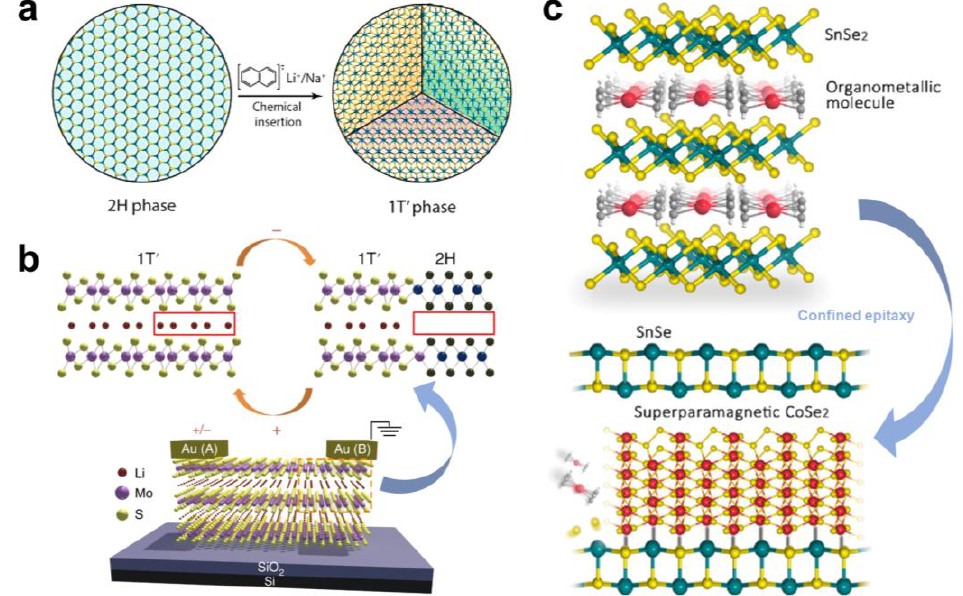
Figure 9. ( a ) Schematic diagram of the 1T’-MoS 2 lattice structure with three orientations formed after lithium intercalation. Reproduced with permission from Ref. [86]. Copyright 2016, American Chemical Society. ( b ) Schematic diagram of the 2H-1T’ phase transition in the MoS 2 lattice by controlling the flow of Li + ions. Reproduced with permission from Ref. [90]. Copyright 2018, Springer Nature. ( c ) Schematic diagram of vdW epitaxial growth of CoSe 2 -SnSe heterostructure. Reproduced with permission from Ref. [92]. Copyright 2022, American Chemical Society.